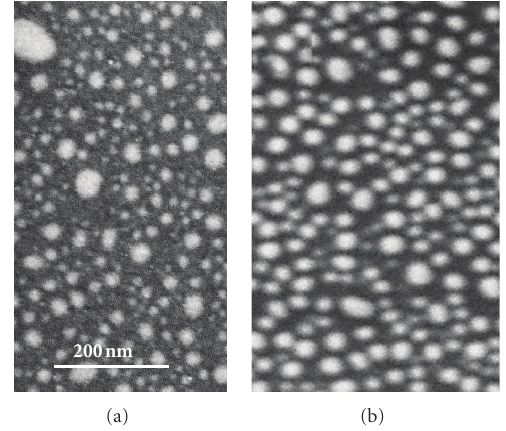
Figure 4: 65 ◦ tilt view SEM image of a sample with both Au and Ge evaporated at 480 ◦ C.